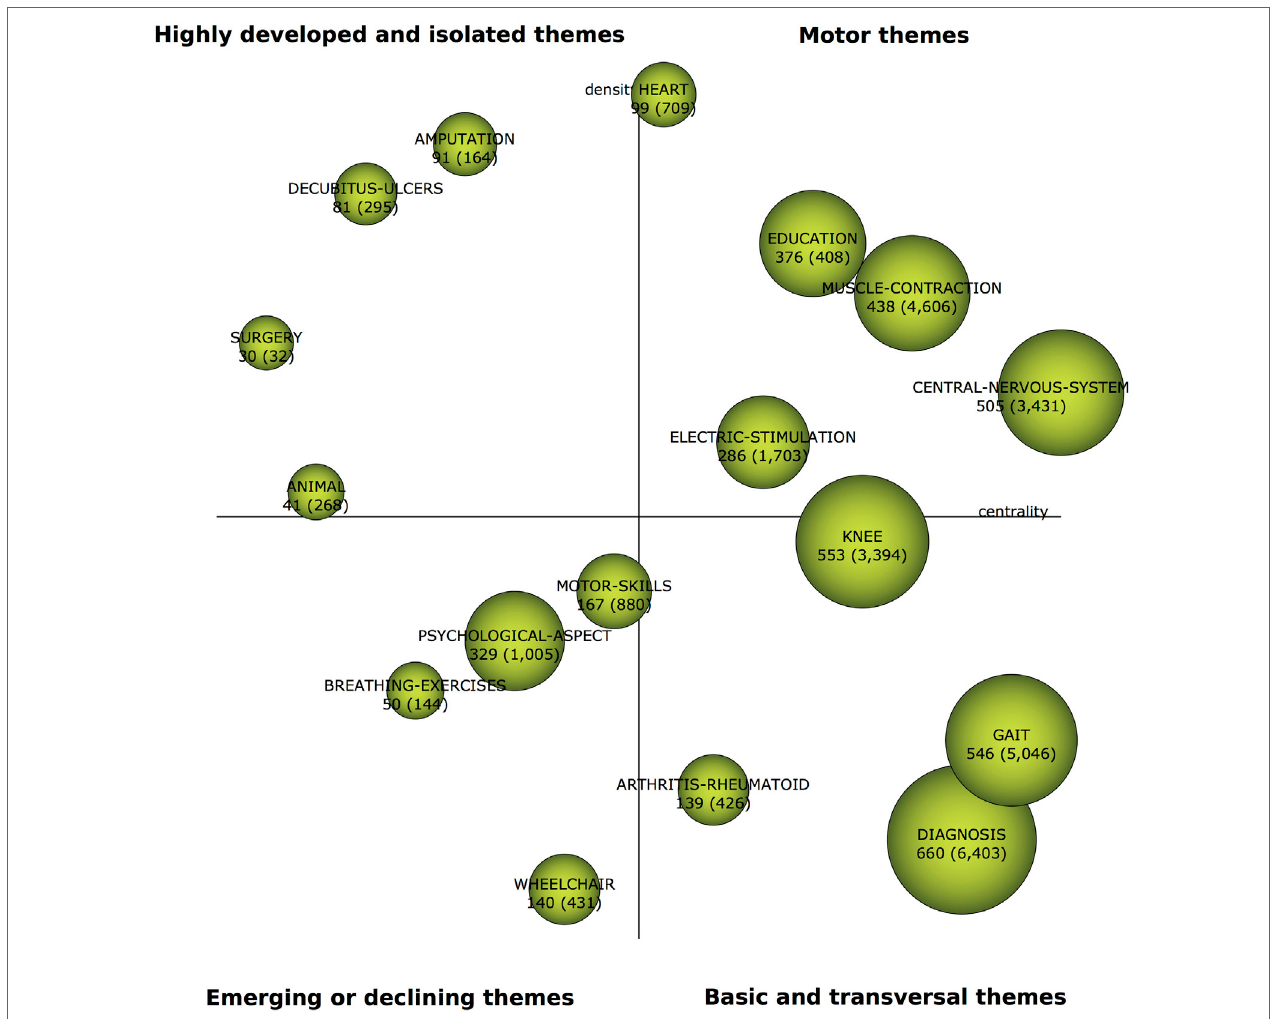
FigUre 3 | Strategic diagram for the subperiod